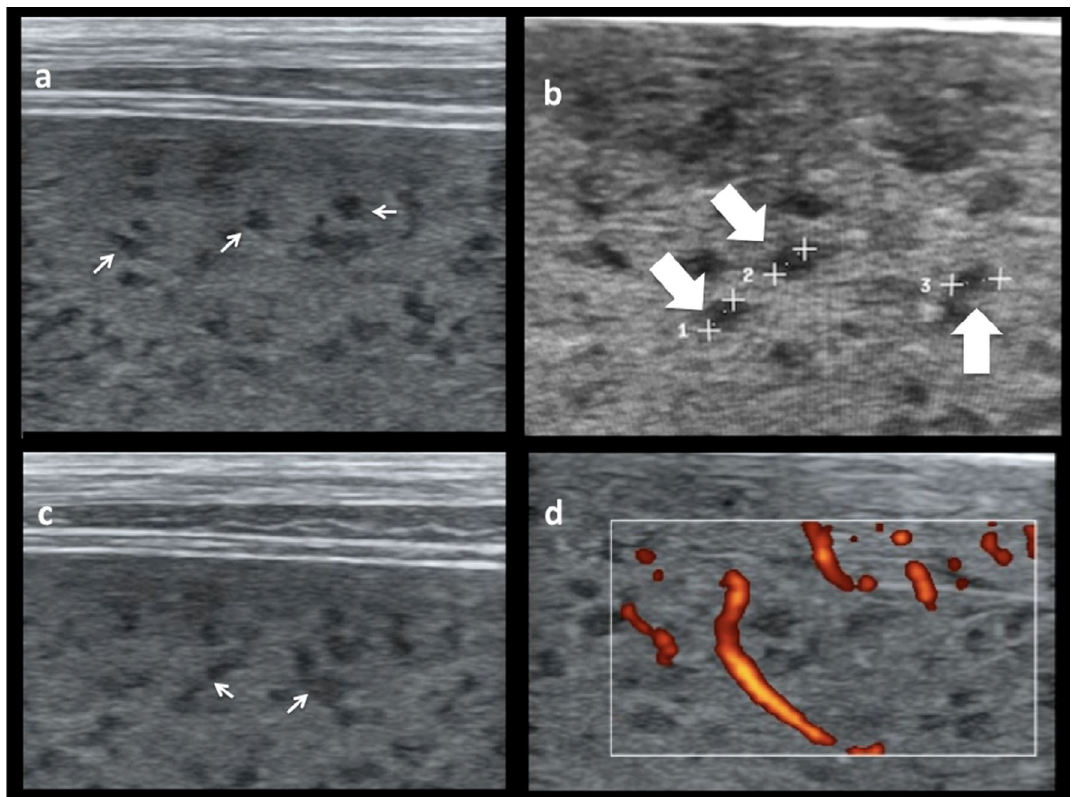
Fig. 1 Sonographic appearance of the spleen of index patient. a Numerous tiny hypoechoic areas (arrows) are seen throughout the splenic tissue. b The areas measure about 2 mm in diameter (Block arrows: 1: 1.9 mm, 2: 2.0 mm, 3: 2.4 mm). c In some still views a more linear appearance is noted which is better visible in the moving scan (see Additional file 1: Video clip S1a). d Using the power mode it can be seen that some of the structures follow the vasculature (see Additional file 2: Video clip S1b); others seem isolated